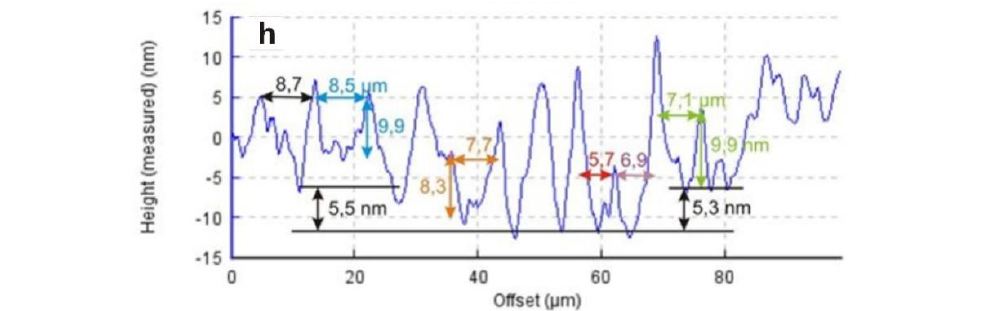
Figure 5. Comparison of enamel block surface morphology after mechanical polishing and ultramicrotomy. ( a ) Reflected-light microscopy (differential interference contrast mode) of mechanically polished enamel showing polishing marks on the enamel surface with enamel (E) and resin (R). ( b ) Confocal laser scanning microscopy of mechanically polished enamel showing scratches and polishing marks. The microstructure of enamel (prisms and interprismatic substance) is not obvious with enamel (E) and resin (R). ( c ) AFM micrograph of mechanically polished enamel depicting scratches and polishing marks. ( d ) Reflected-light microscopy of the enamel block surface after ultramicrotomy, showing the microstructure of enamel (prisms and interprismatic substance) with enamel (E) and resin (R). ( e ) Confocal laser scanning microscopy of the enamel surface after ultramicrotome preparation, depicting numerous prisms and the interprismatic substance with enamel (E) and resin (R). ( f ) AFM micrograph of the enamel surface after ultramicrotome preparation showing numerous prisms (dark red area) and the interprismatic substance (yellow area). ( g ) Horizontal height profile of the mechanically polished enamel surface measured by AFM, showing the surface roughness at the microscale in detail. ( h ) Horizontal height profile of the same enamel sample after ultramicrotome preparation, measured by AFM.